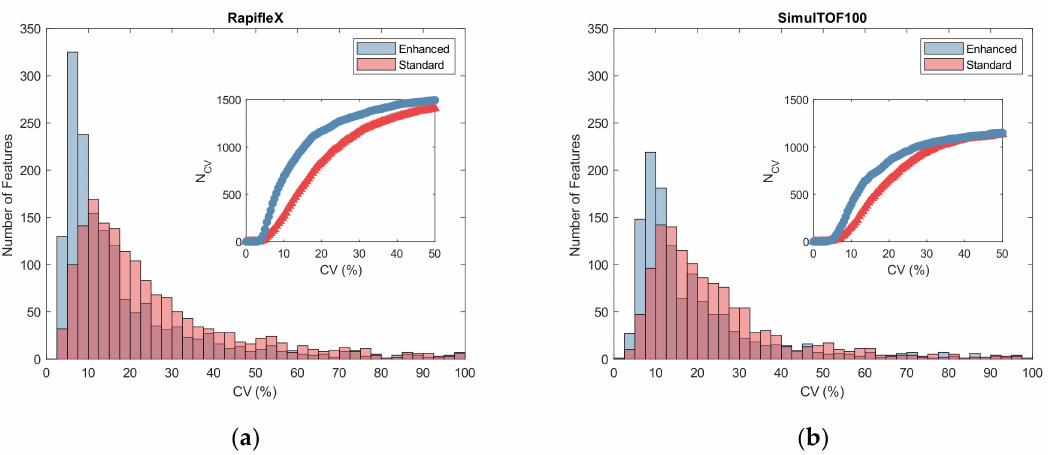
Figure 6. Reproducibility of feature values for a single sample over 20 preparations and acquisitions collected on the ( a ) RapifleX and ( b ) SimulTOF100. Histograms of CVs for standard (red) and enhanced (blue) feature values are shown in the main plot. The inset shows the cumulative CV distribution, N CV , for the standard (red, triangles) and enhanced feature values (blue, circles) (only CVs up to 50% are shown for